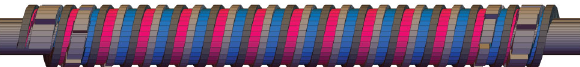
FIG. 13. A model of the HSCU with 13.5 periods and a period length of 31.5 mm. The end turn-around structure is approxi- mated and the steel mold is not shown, although the mold is included in the model and